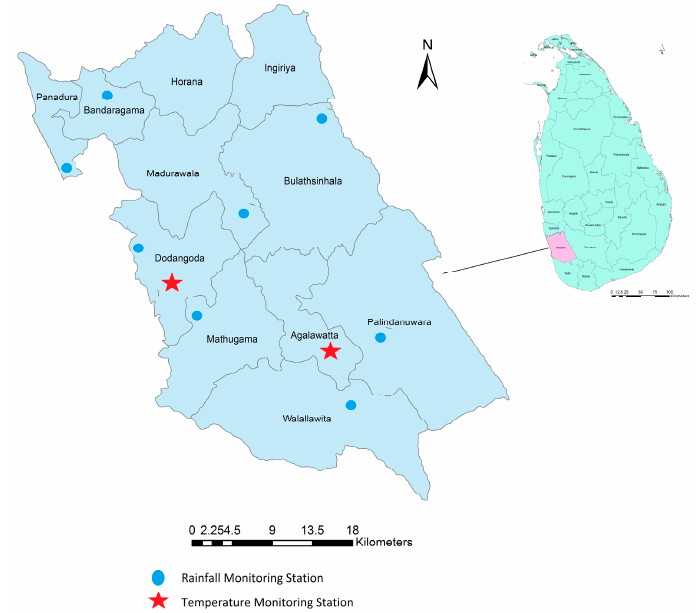
Figure 1. Map showing the MOH divisions and the geographical location of meteorological monitoring stations in Kalutara district, Sri Lanka. The solid line shows the boundaries of the MOH divisions in the district. The blue dots in the map represent the rainfall stations, and the red stars represent the temperature monitoring